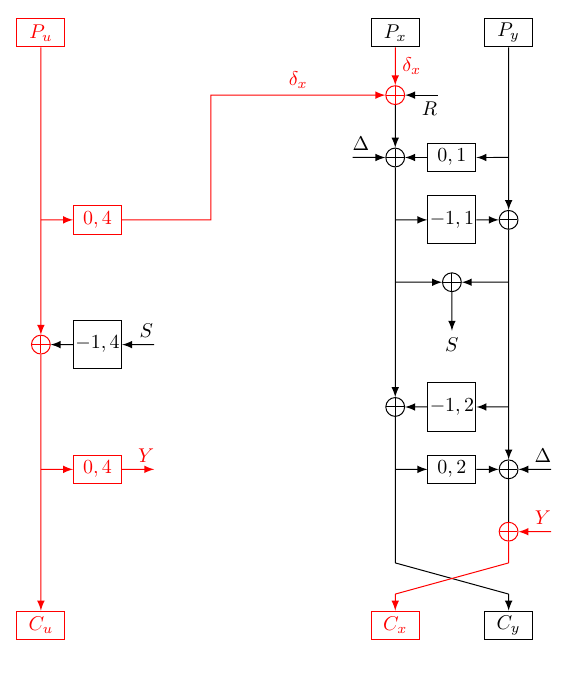
Figure 6: Difference propagation within AEZ-core